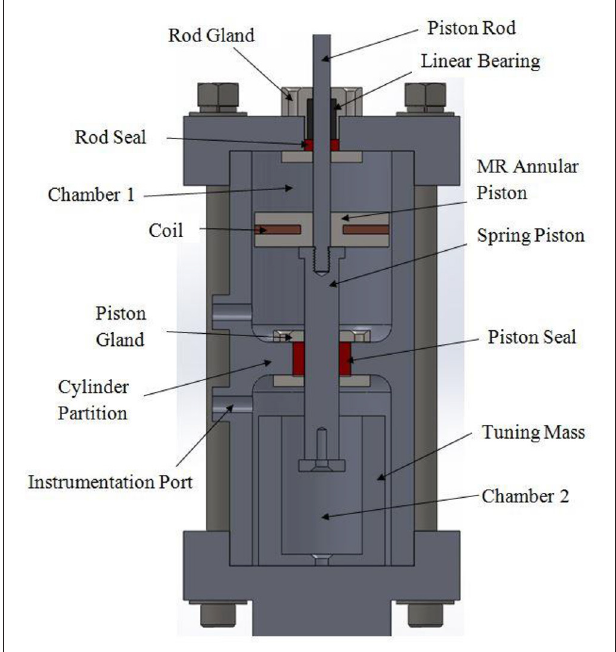
FIGURE 1 | A cross-sectional view of the BDLS-CMRD shows the general arrangement including: seals, pistons, glands, and tuning mass. Reproduced with permission from Maus and Gordaninejad